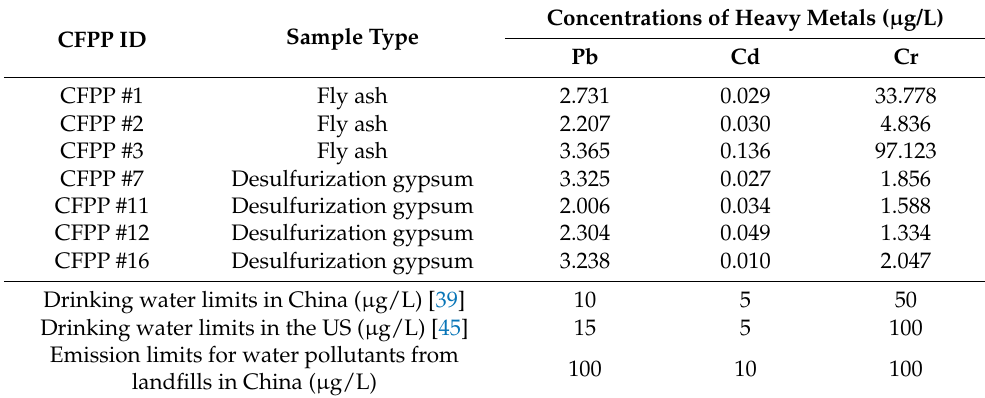
Table 4. Heavy-metal release from FA and FGD gypsum under simulated rainfall leaching conditions.